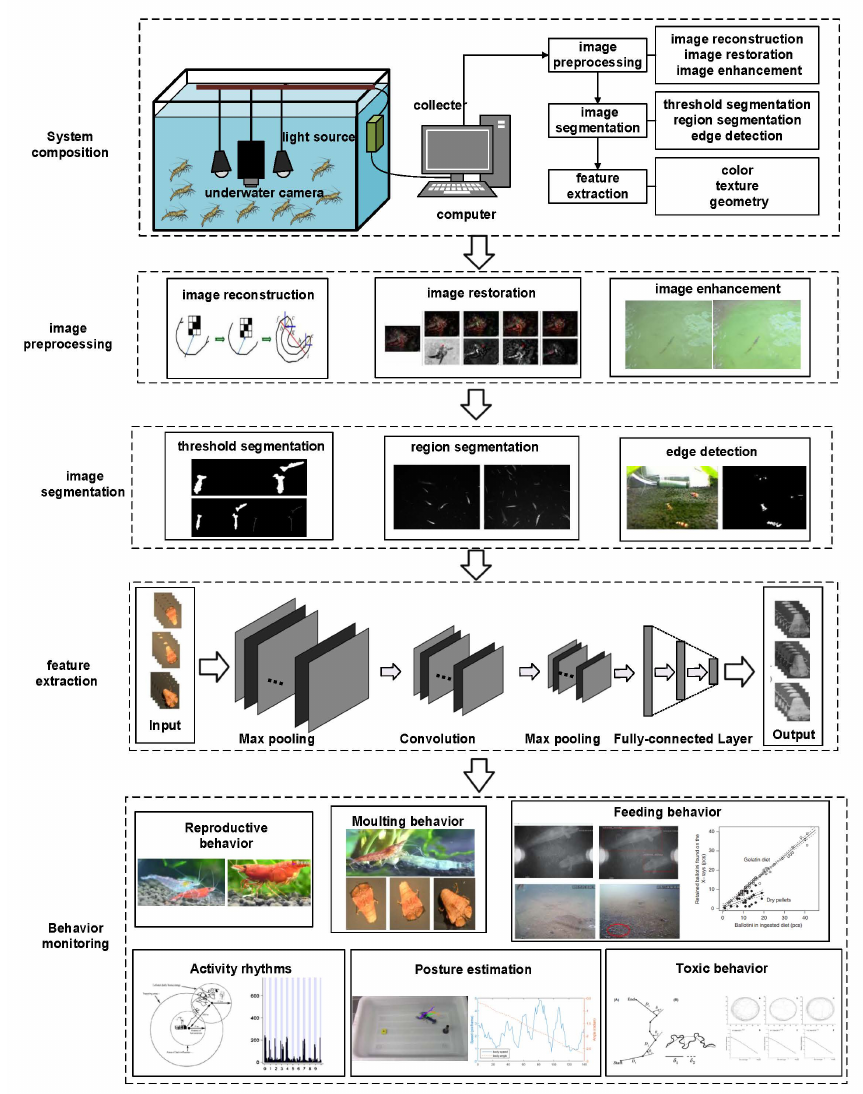
Figure 3. System structure and monitoring flow